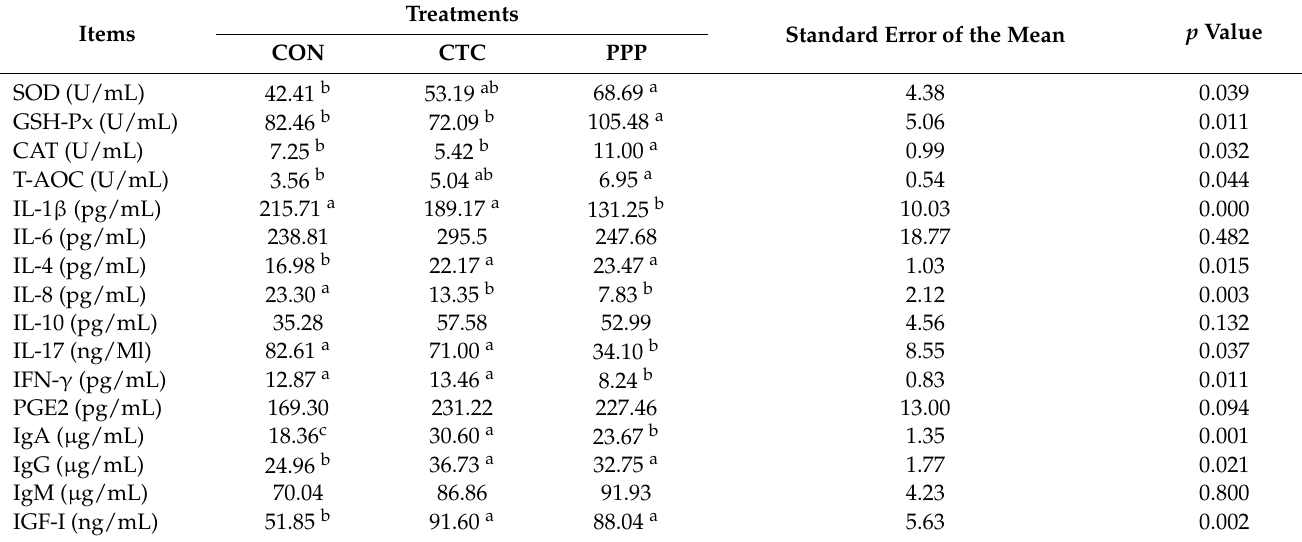
Table 3. Dietary pomelo peel powder affected serum cytokines and immunoglobulin concentrations of weaned piglets.